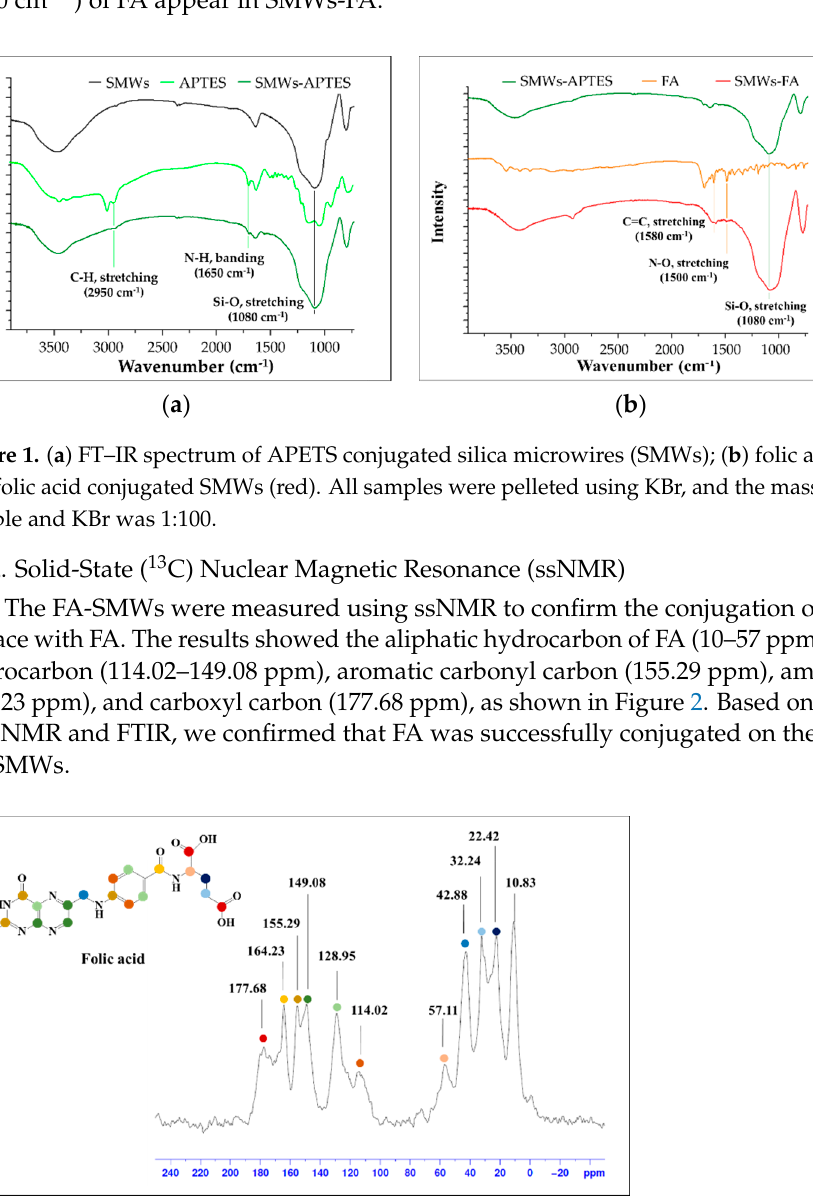
Figure 2. Solid-state ( 13 C) nuclear magnetic resonance (ssNMR) spectrum of folic acid-conjugated SMWs. The peak in folic acid, which can be identified through ssNMR, is indicated by the same color in the molecular